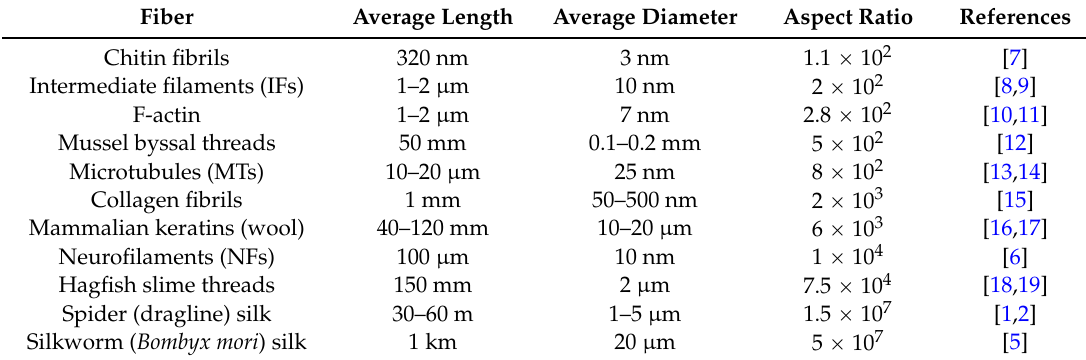
Table 1. Examples of fibers in biology, from lowest to highest aspect ratio.